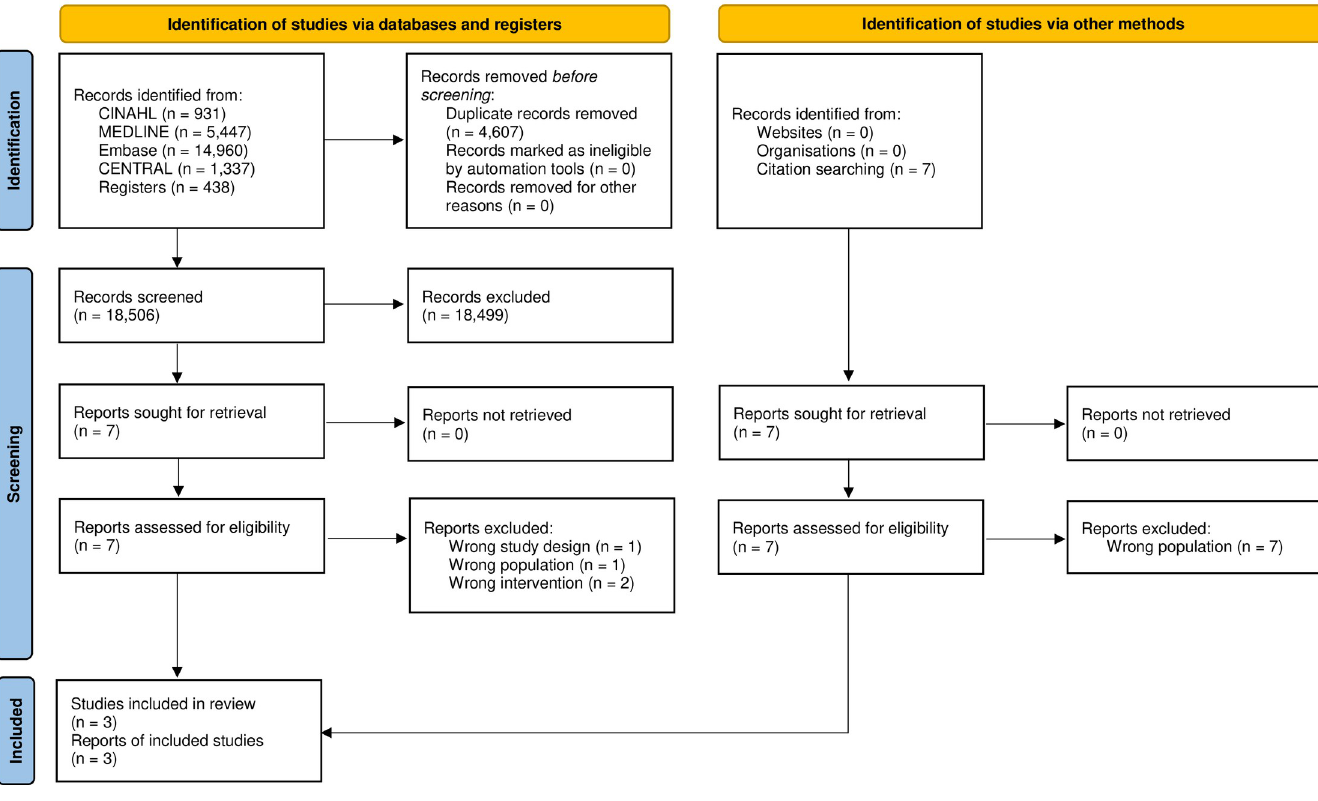
Fig 1. PRISMA flow